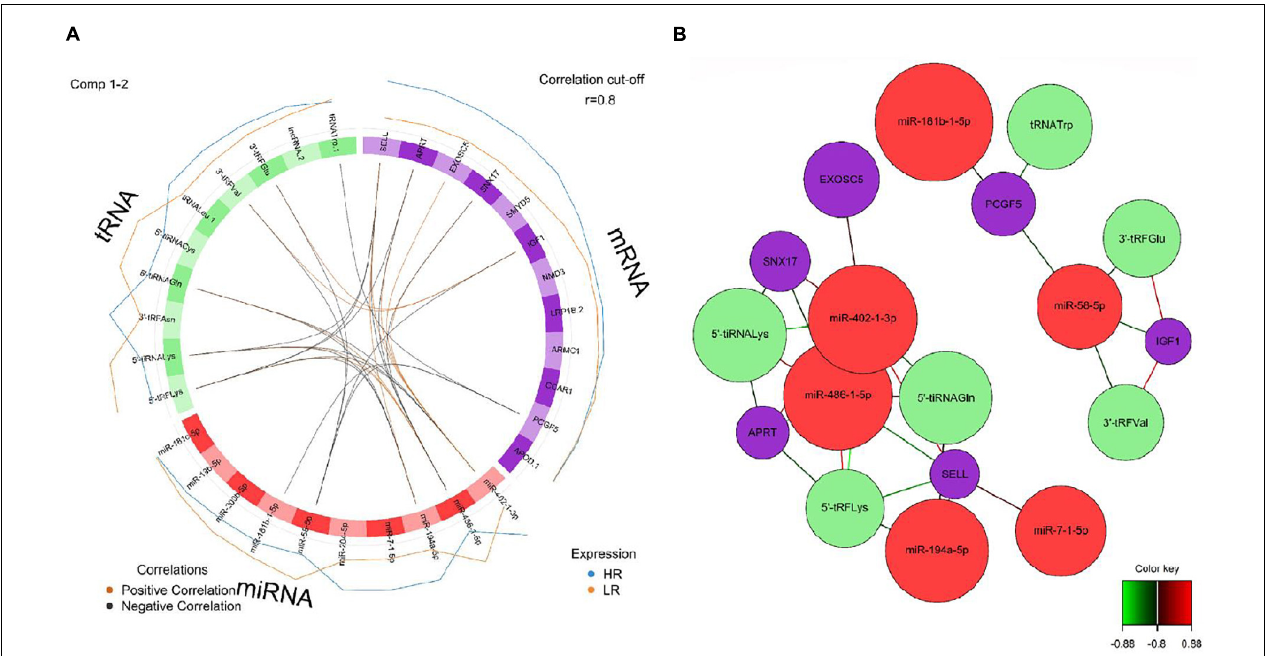
FIGURE 7 | (A) Circos plot of mRNA, miRNA, and tRNA linked to coping behavior haplotype groups in the amygdala. Positive correlations are indicated by brown-colored connectors, while black connectors indicate negative correlation between mRNA, miRNA, and tRNA. Blue and orange colored lines in the outer circle highlight expression levels in either high (HR) or low (LR) reactive coping group. (B) Network visualization of mRNA, miRNA and tRNA panels indicating correlated variables in the amygdala ( r > | 0.80|). Purple colored nodes represent mRNA, red nodes indicate miRNA and green nodes highlight tRNA biomarkers. Correlation between nodes is indicated by edge color as shown in the color key. Negative correlation is depicted by green edges, while red edges represent positive correlation.